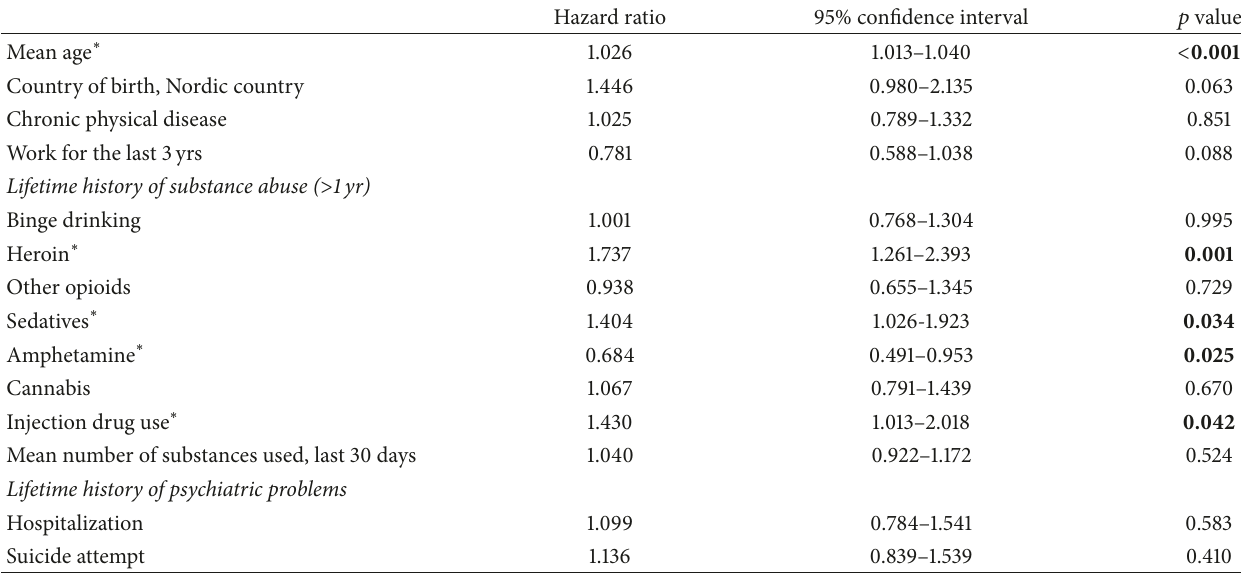
Table 3: Men: mortality risk